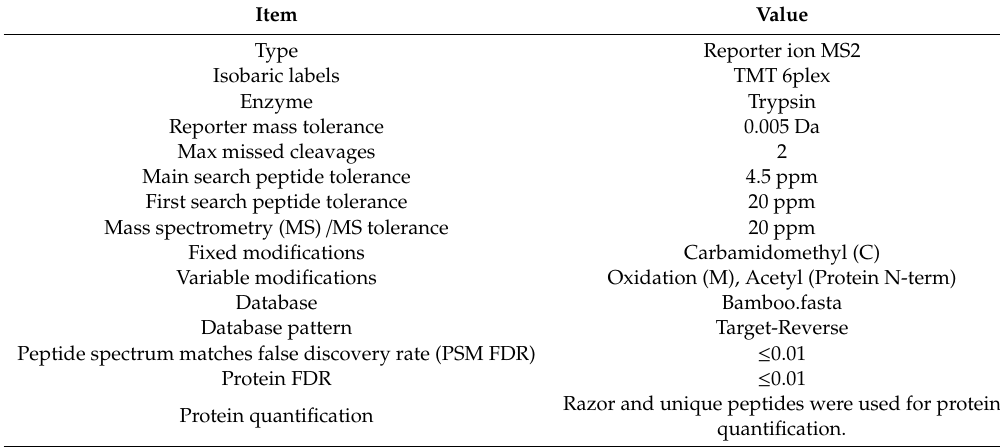
Table 4. MaxQuant search library parameter